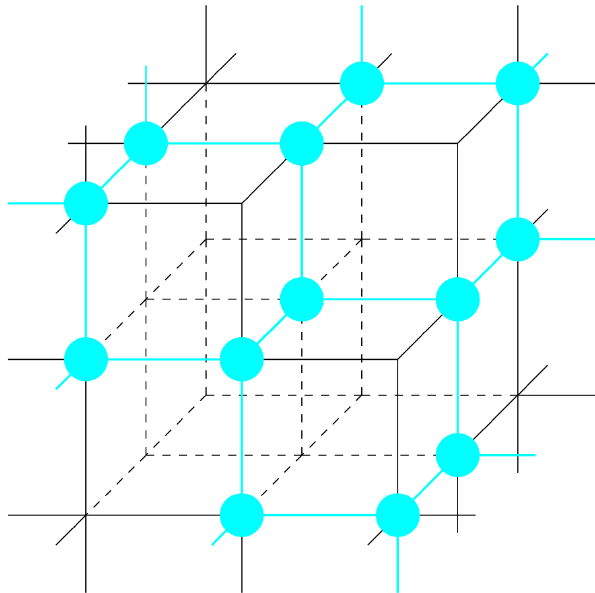
Figure 6. Illustration of the mapping from (cid:48) (cid:54) to X ( 1 ) showing how the dual graph sits inside the three-dimensional cubical